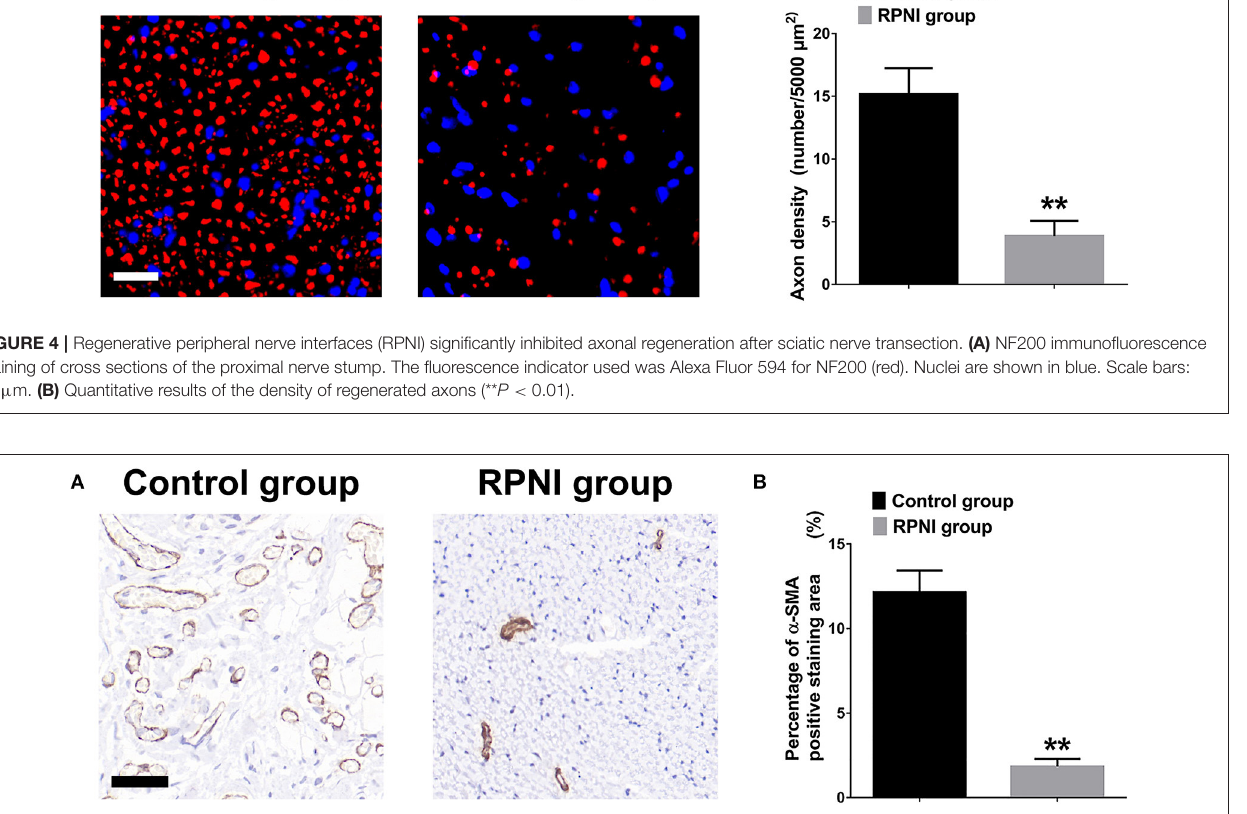
FIGURE 5 | Regenerative peripheral nerve interfaces (RPNI) effectively reduced the degree of neural fibrosis in the sciatic nerve stump. (A) α -SMA immunohistochemical staining (brown) of cross sections of the proximal nerve stump. Scale bars: 40 µ m. (B) Quantitative results of the percentage of α -SMA positive staining area (** P <